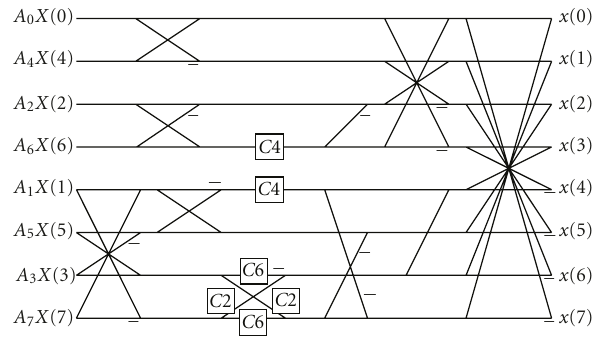
Figure 1: The flow graph of AAN n = 8. Figure 2: The revised flow graph of AAN n = 8